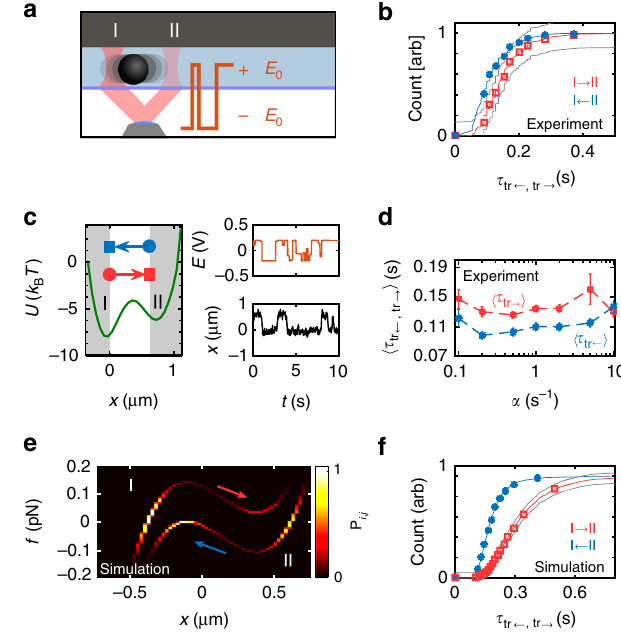
Fig. 4 Transition times of particles between two potential minima in micro fl uidic experiments and simulations. a Bistable potential created by a strong and weak optical trap under stochastically switching voltage ±E 0 . b Symmetry breaking in the cumulative distribution of transition times I → II (red) and I ← II (blue). c Mean potential U and the fi rst ten seconds of the position x ( t ) and the measured voltage E ( t ). Brief jumps in the telegraph process cannot be resolved and appear as averages between the two voltage levels. d Mean transition times 〈 τ ← , → 〉 over the decorrelation rate α of the electrical fi eld process. Error bars show the standard error of the mean. e Colour map representing the relative occupation of states in the position × force plane under the in fl uence of an external, coloured force. f here denotes the total force f = f − d U /d x . f Cumulative distribution ext